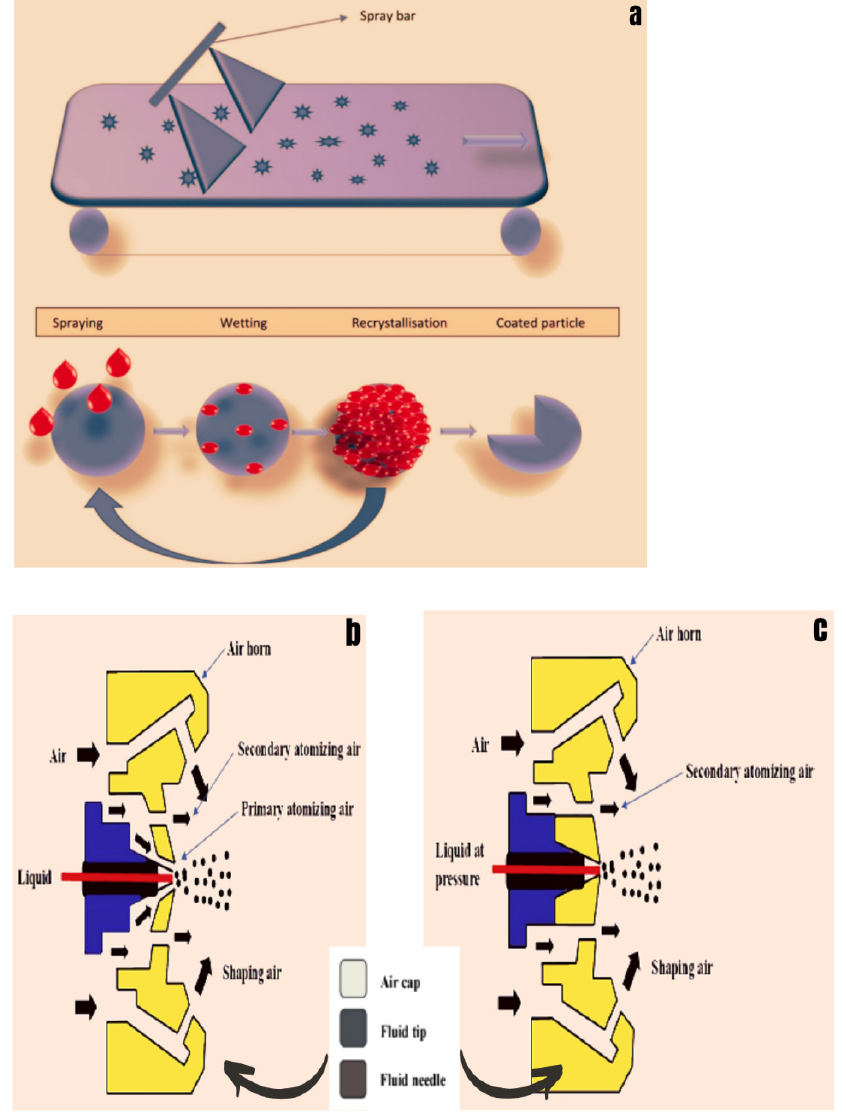
Figure 7. ( a ) Spraying method for applying the edible coating. ( b ) Air spray atomization. ( c ) Air- aided airless atomization. Adopted from [194] with permission.